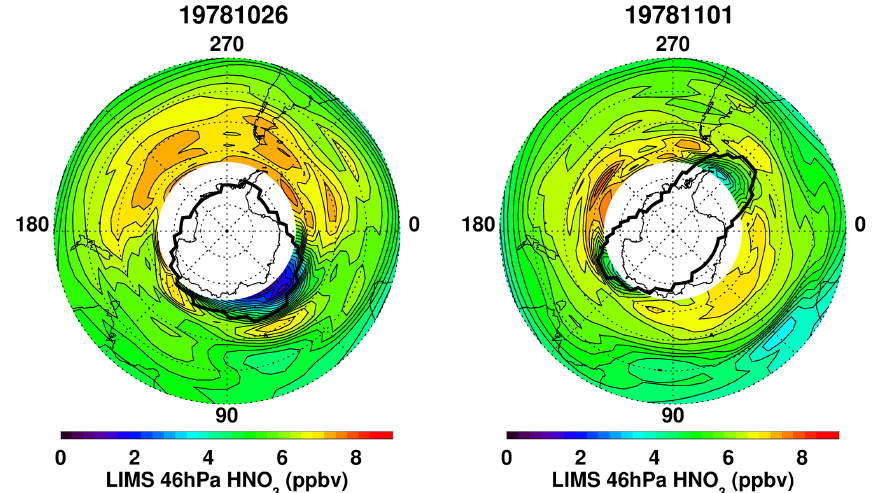
Figure 4. As in Fig. 2, but for V6 HNO 3 .